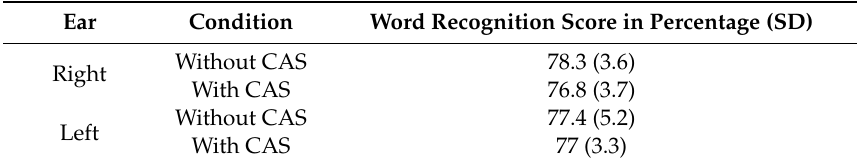
Table 2. Descriptive statistics of word recognition scores without and with contralateral acoustic stimulation (CAS) in the two ears. SD = Standard Deviation.